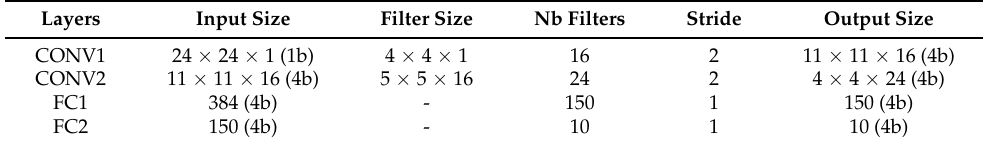
Table 1. Description of the neural network model